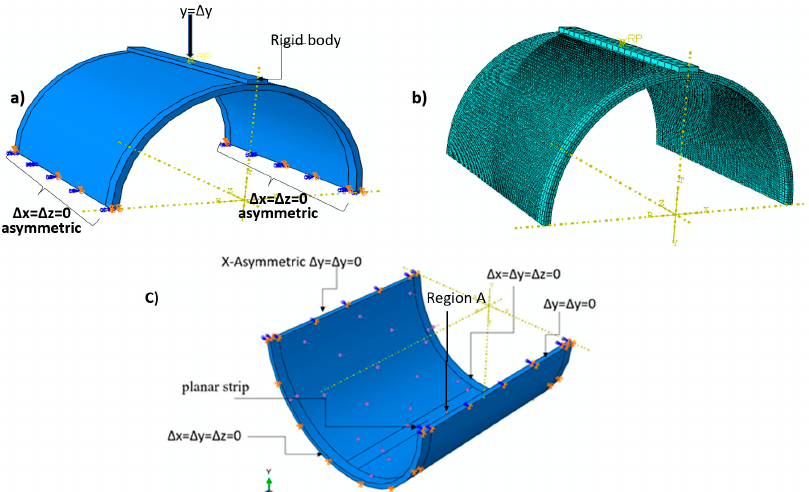
Figure 7. ( a ) Boundary condition, ( b ) mesh shape finite element domain, ( c ) domain with crack.